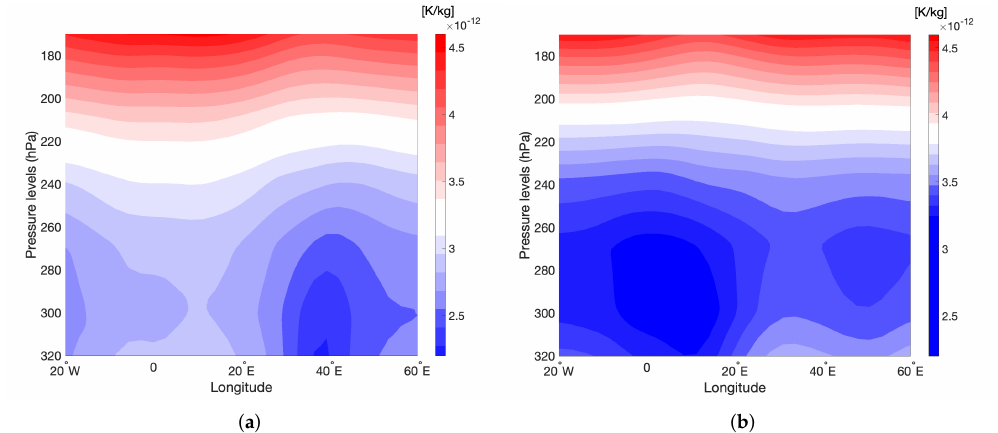
Figure 10. Meridional mean O 3 aCCFs on ( a ) 1 February 2016 and ( b ) 1 August 2016. Pressure levels (hPa) correspond to cruise flight levels used for vertical re-routing.